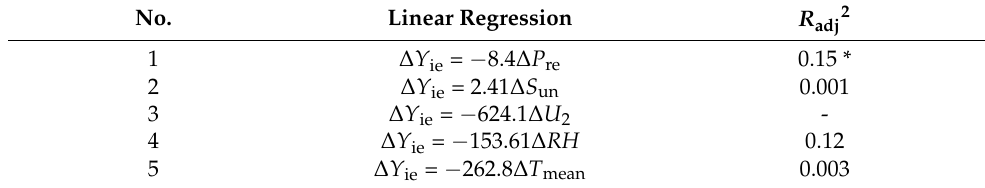
Table 4. The linear equations for ∆ Y ie at